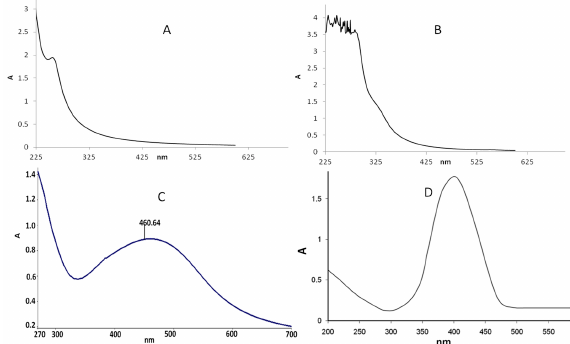
Figure 2. ( A ) UV-visible spectra of 1 mM AgNO 3 ; ( B ) C. glabrata supernatant before the addition of AgNO 3 , ( C ) after addition AgNO 3 (biosynthesized AgNPs), and ( D ) commercially available spectra